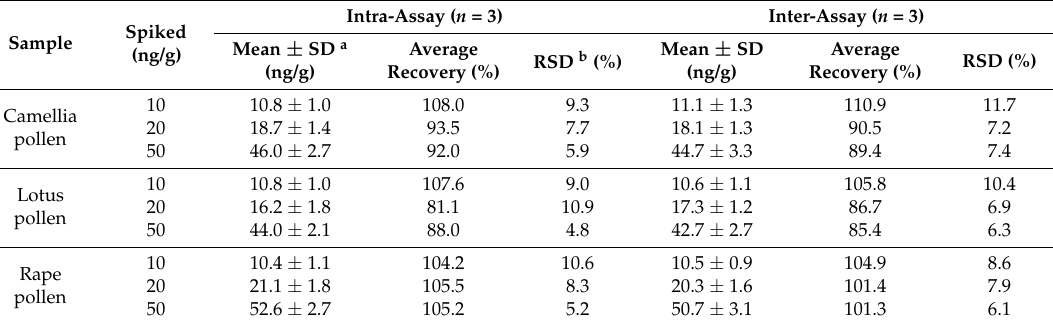
Table 2. Recovery studies of sample spiked with acetamiprid by